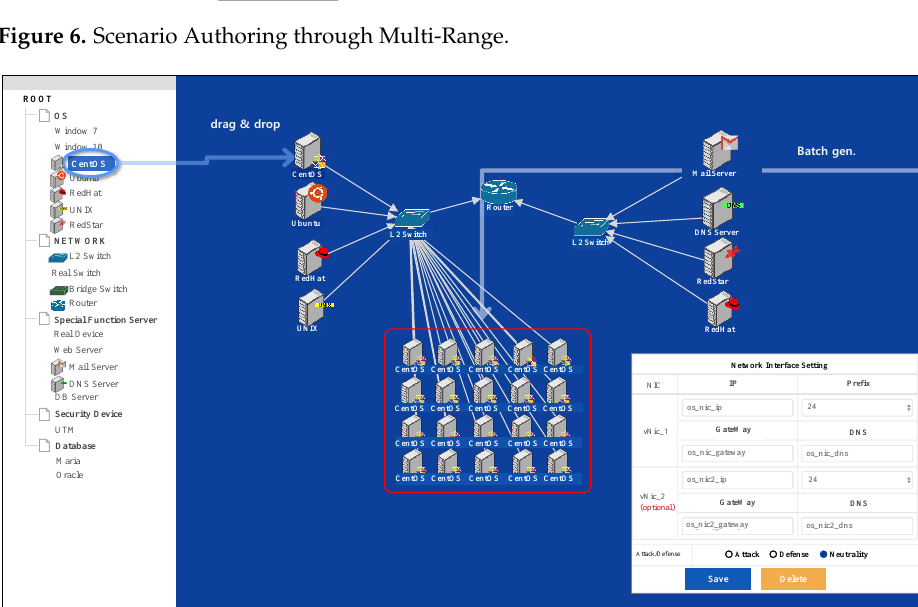
Figure 7. Network Map Configuration Function.